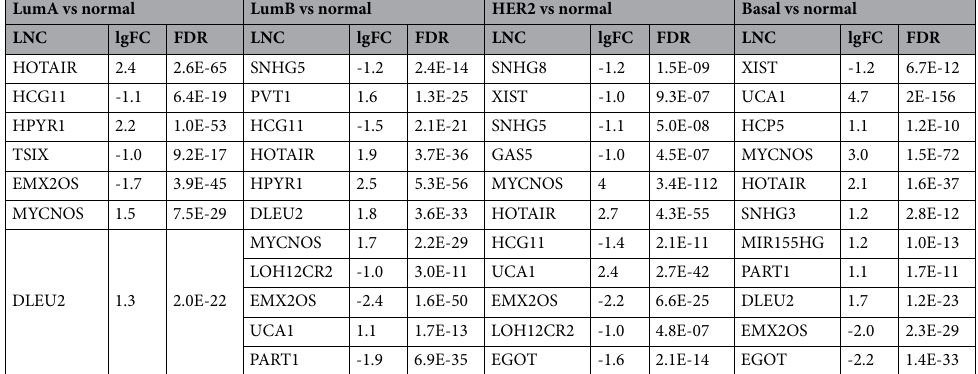
Table 1. Differentially expressed long non-coding (LNC) RNAs in luminal A, luminal B, HER2 and basal breast cancer. LgGC log-fold change, FDR false discovery rate.